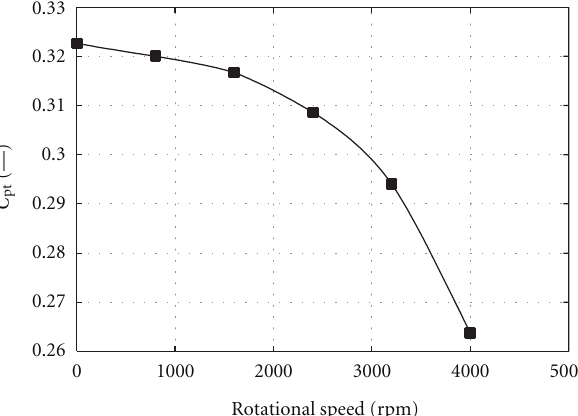
Figure 15: Mass-averaged total pressure loss coe ffi cient versus rotational